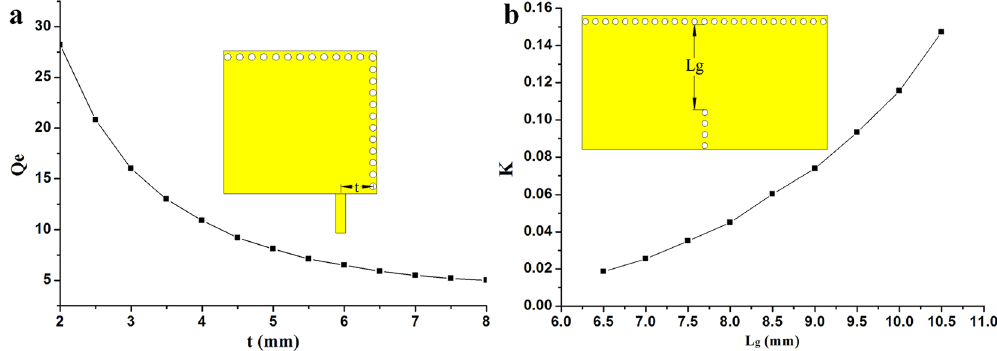
Figure 7. ( a ) Extracted external Q e and ( b ) coupling coefficient K